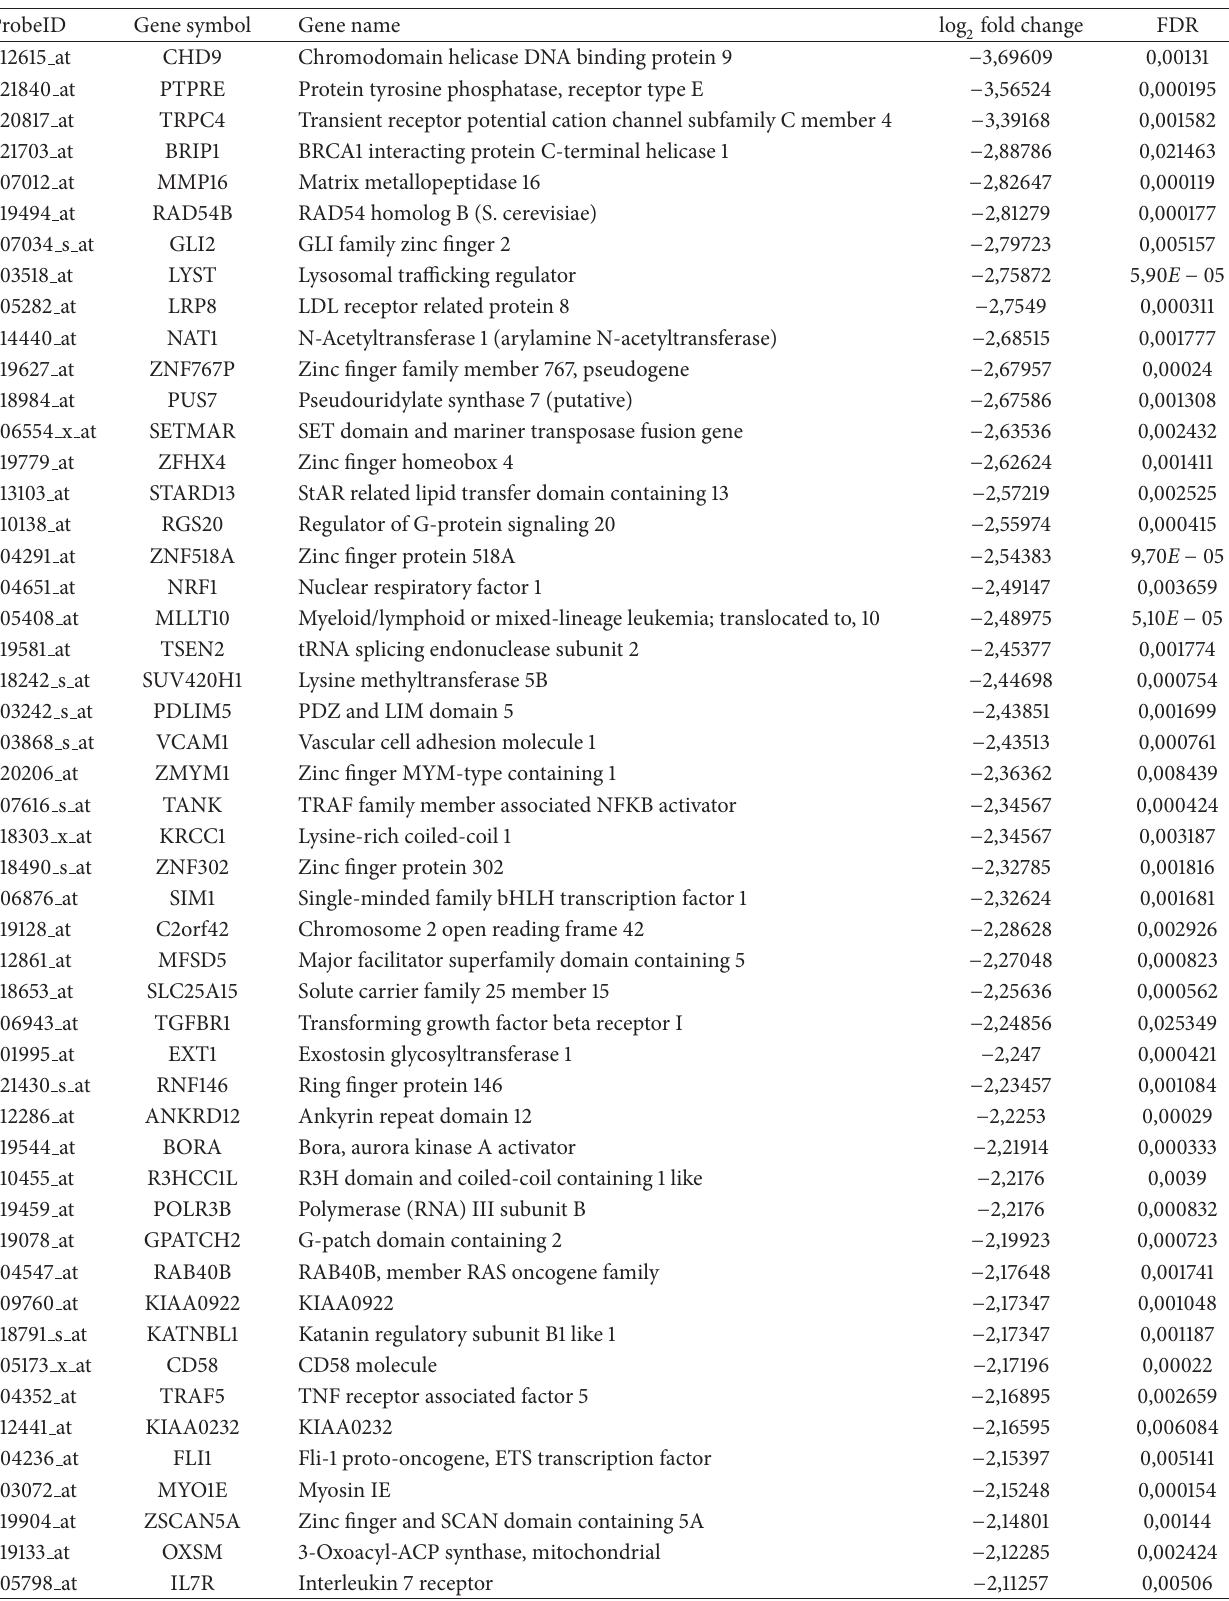
Table 2: Top hundred differentially expressed genes identified in dataset